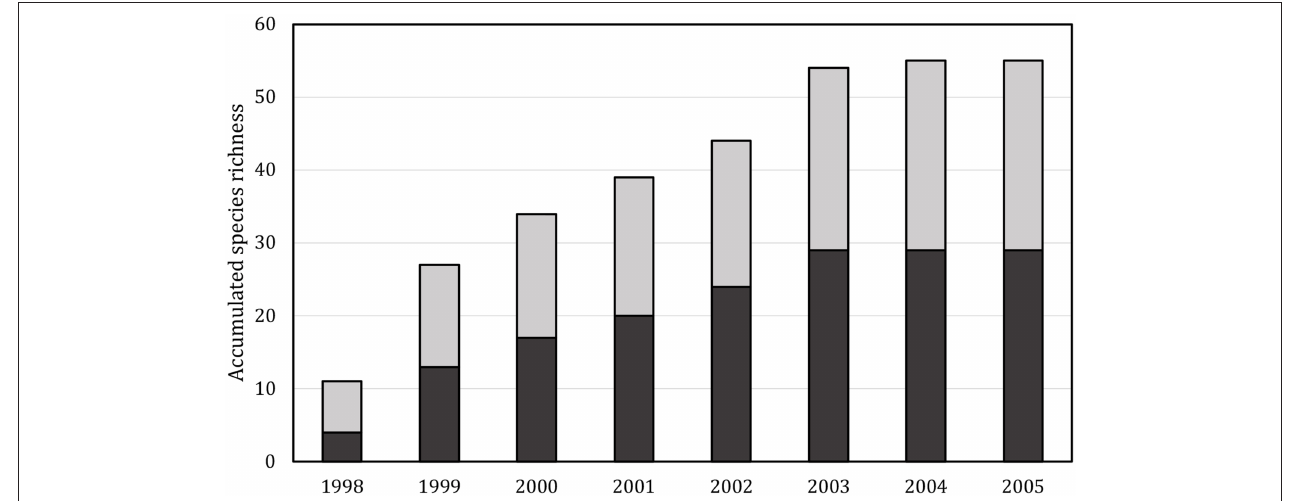
FIGURE 4 | Mean, cumulative number of observed species in the artificial pond. Black: copepods, gray: